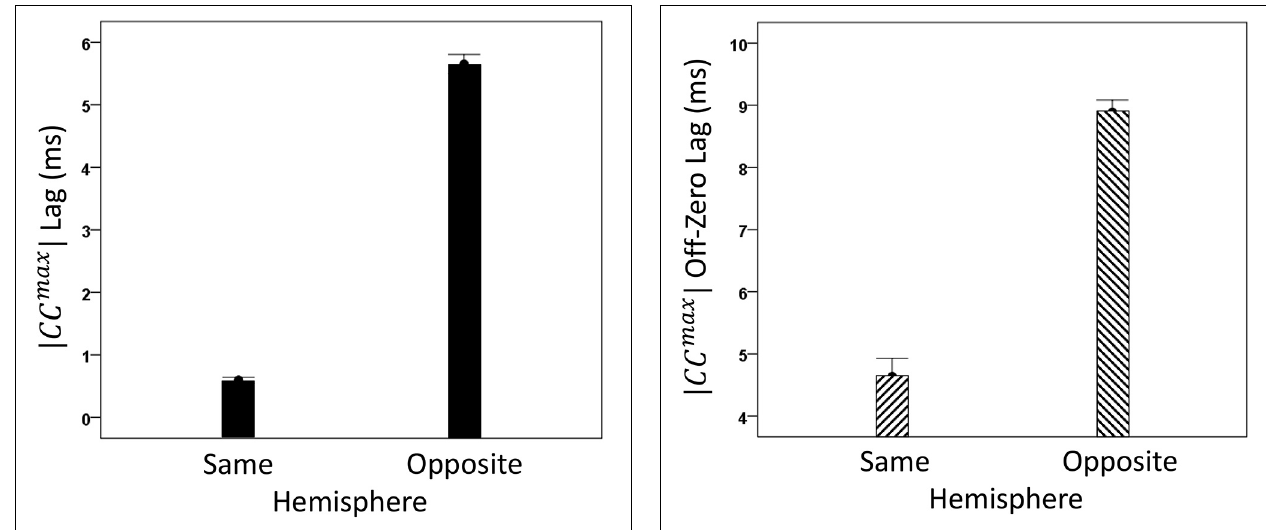
(cid:2) (cid:2) (cid:2) CC max (cid:2) for same- and opposite